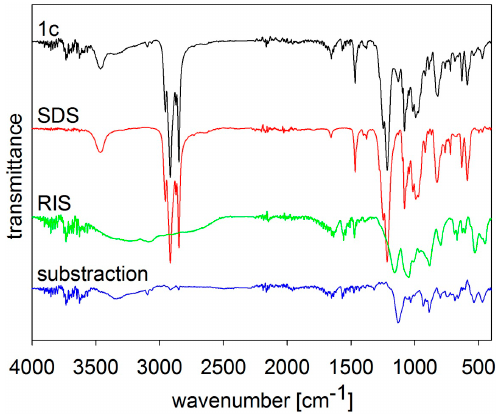
Figure 2. MIR spectra of risedronate (RIS), sodium dodecyl sulfate (SDS) and risedronate nanoparticles stabilized with 5% concentration of sodium dodecyl sulfate (Sample 1c ) and differential